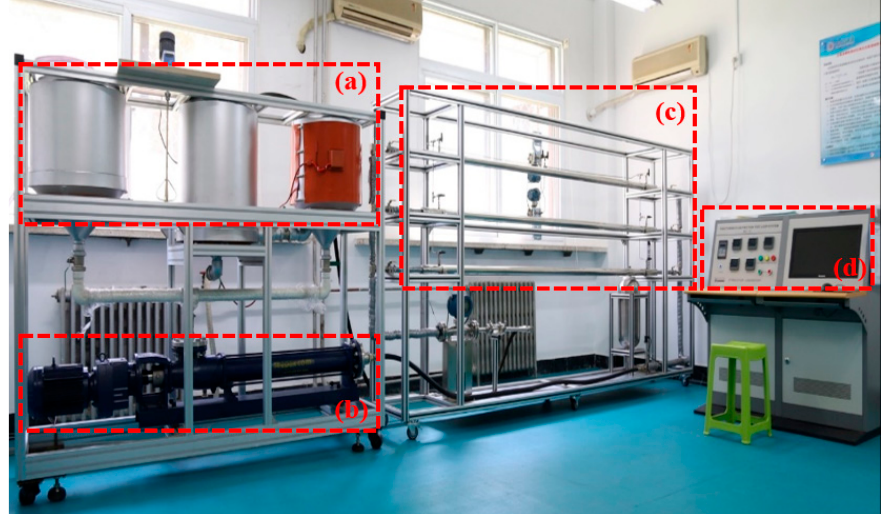
Figure 1. The YMC-2 type loop friction test system. ( a ) liquid supply system, ( b ) screw pump, ( c ) pipeline system, and ( d ) integrated control computer